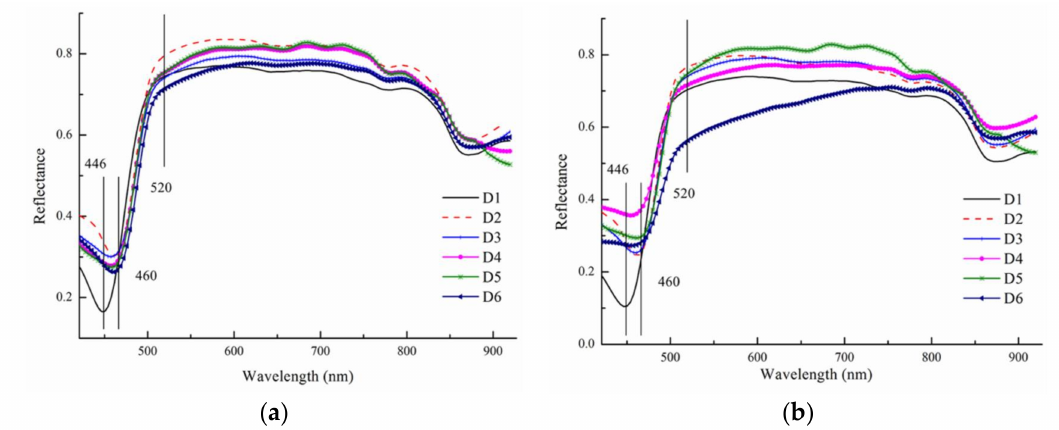
Figure 2. ( a ) Average spectra of A. flavus and ( b ) average spectra of A. parasiticus .